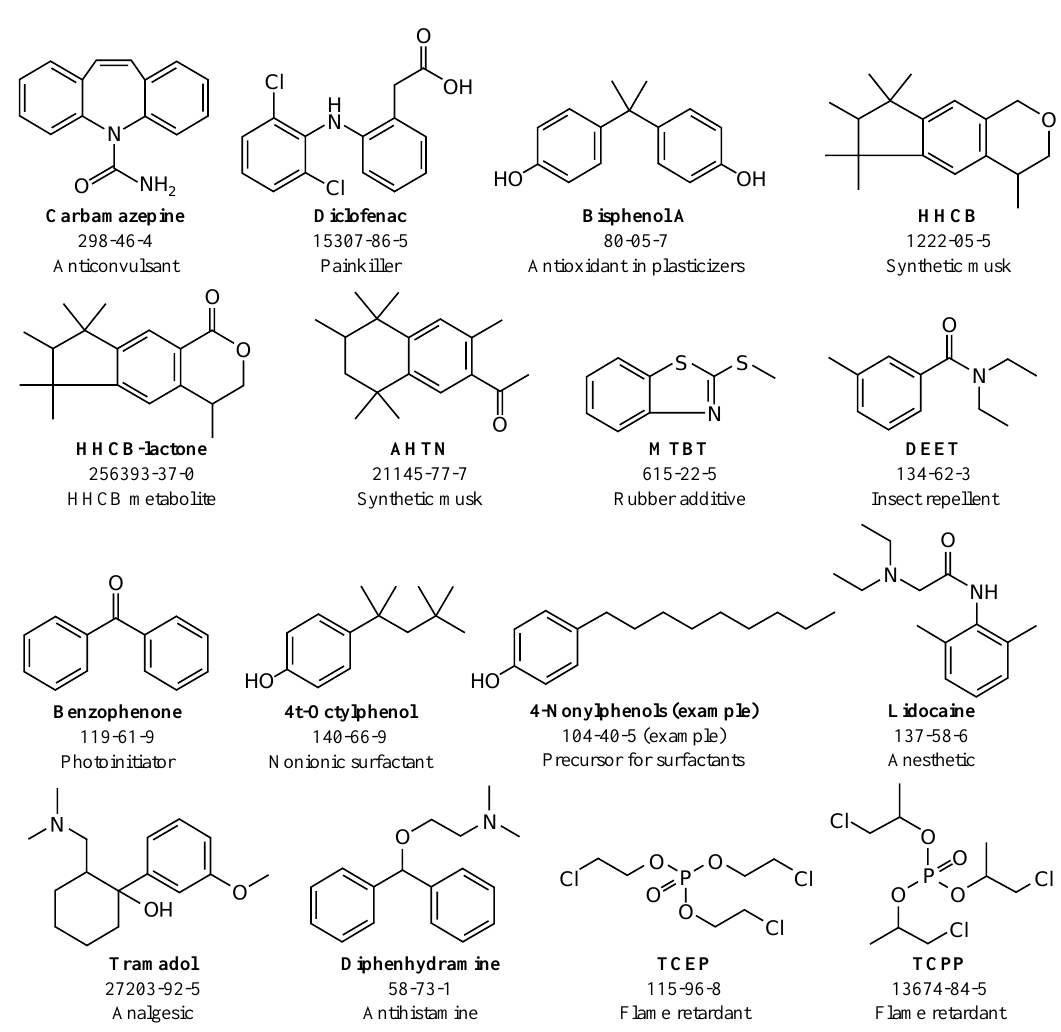
Figure 2. Emerging contaminants analyzed in WWTE samples with CAS numbers (Rott et al. [7] based on [18]).